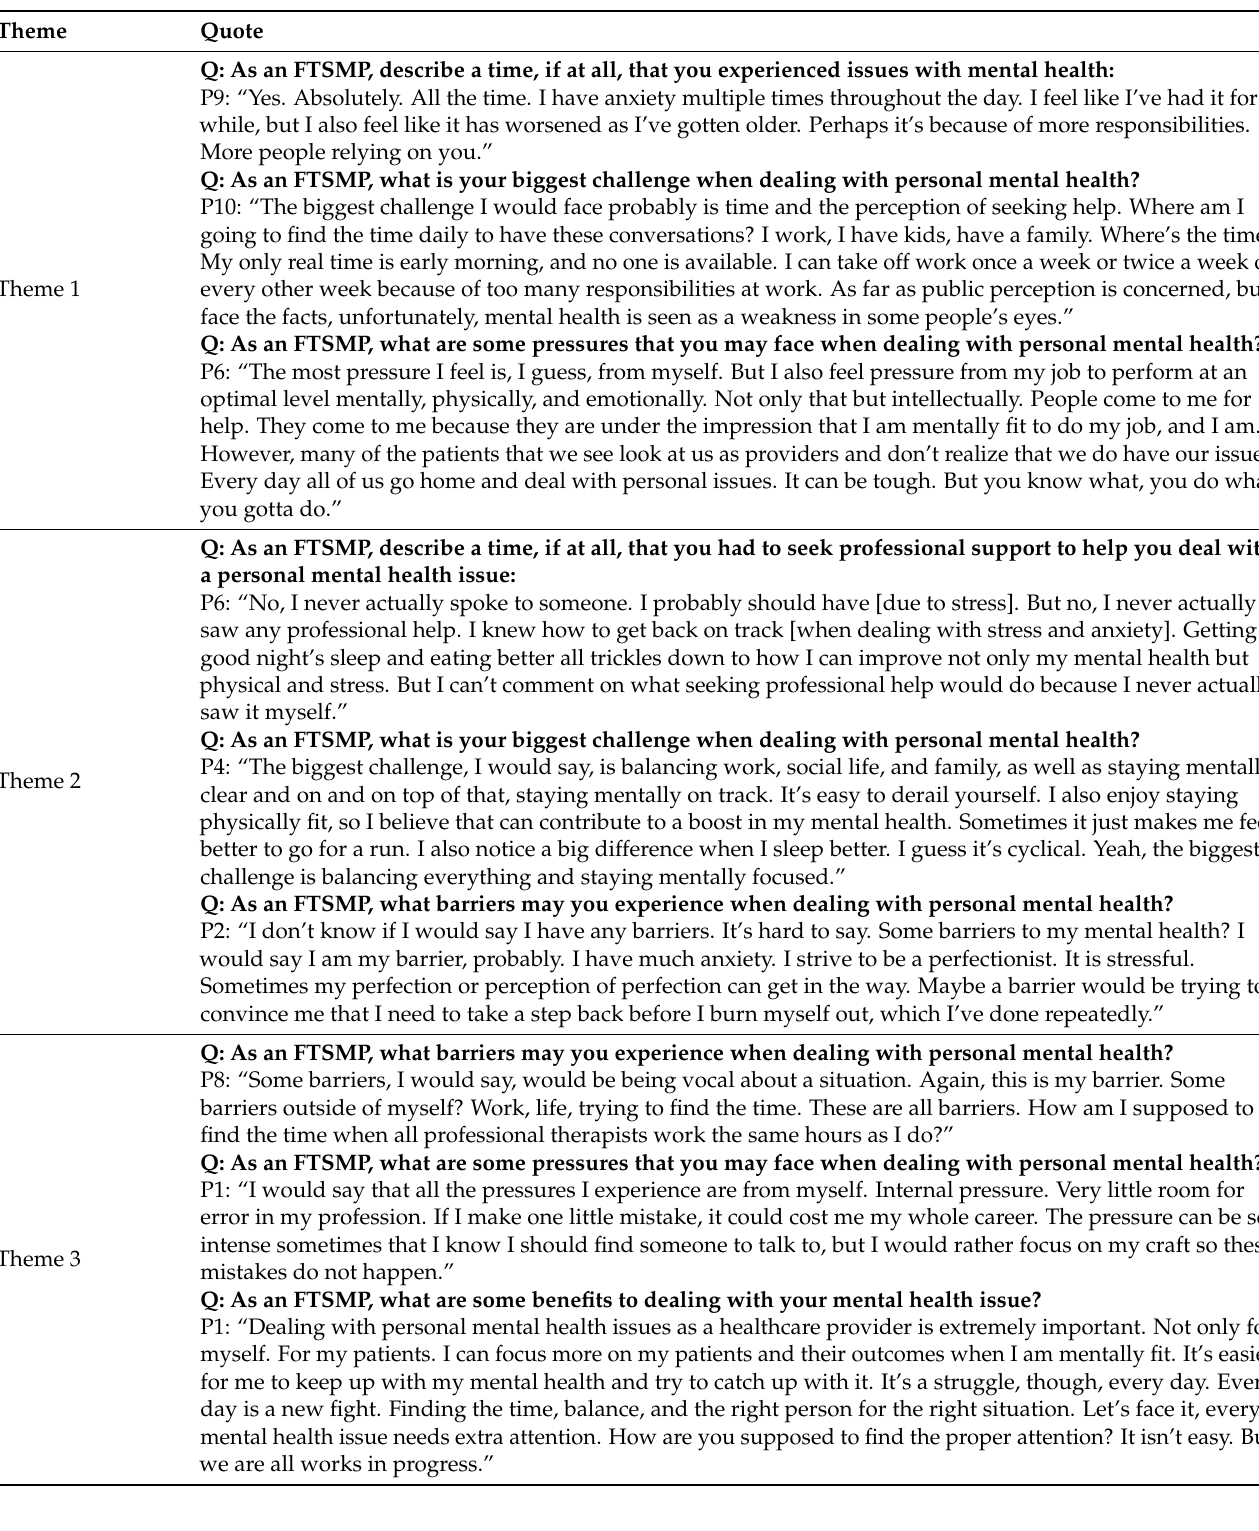
Table 6. Example of Robust Quotes Used to Make